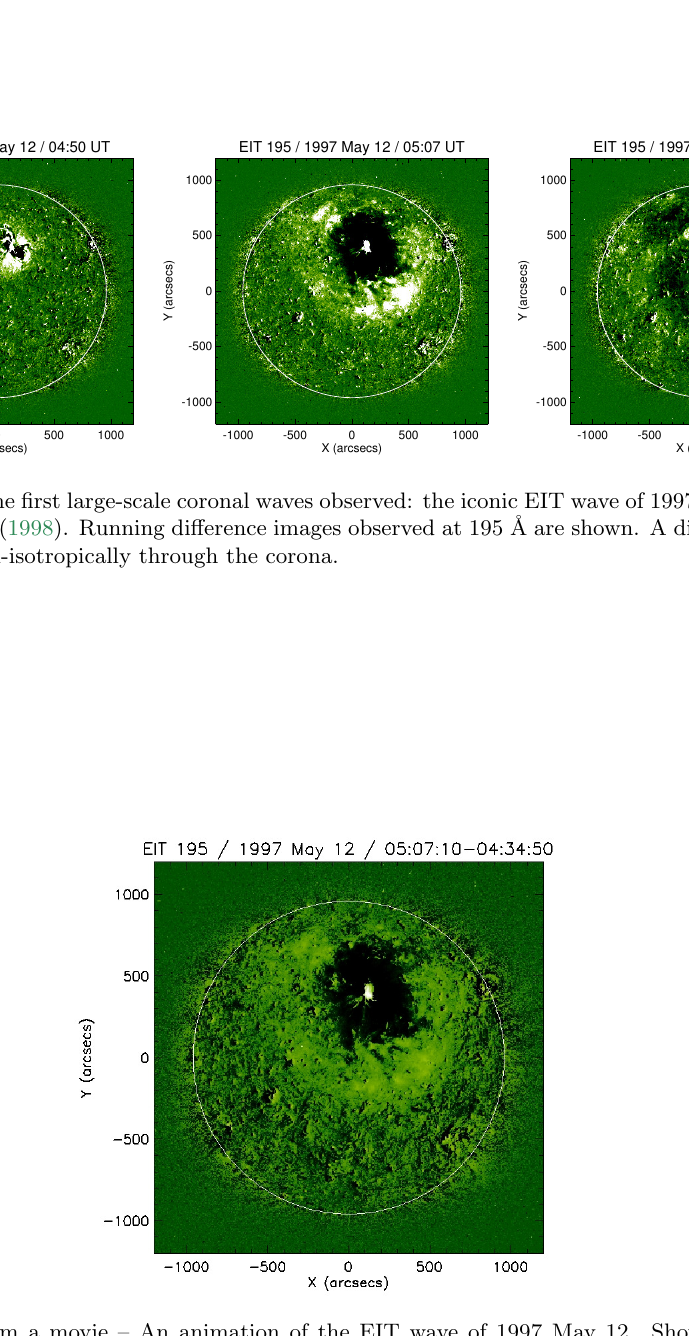
Figure 4: Still from a movie – An animation of the EIT wave of 1997 May 12. Shown is a sequence of base difference images obtained at 195 ˚A. (To watch the movie, please go to the online version of